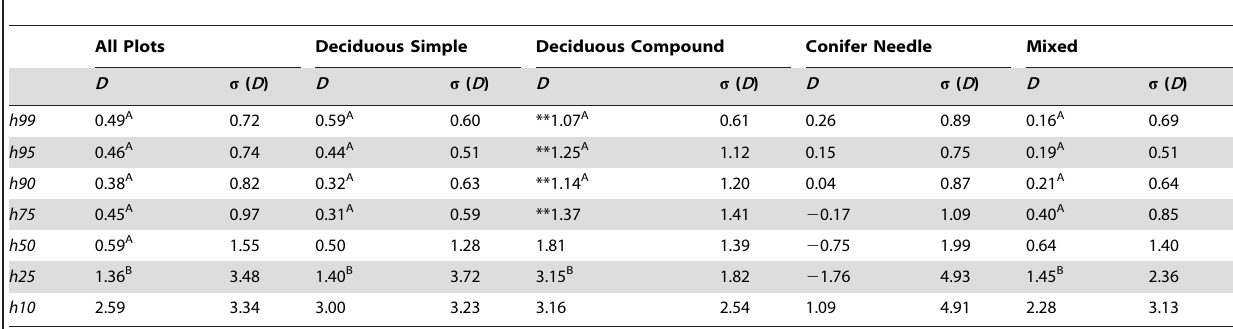
Table 8. Mean differences ( D , leaf-on lidar minus leaf-off lidar) between leaf-on and leaf-off lidar percentile height values and associated standard deviation ( s ) of mean differences in